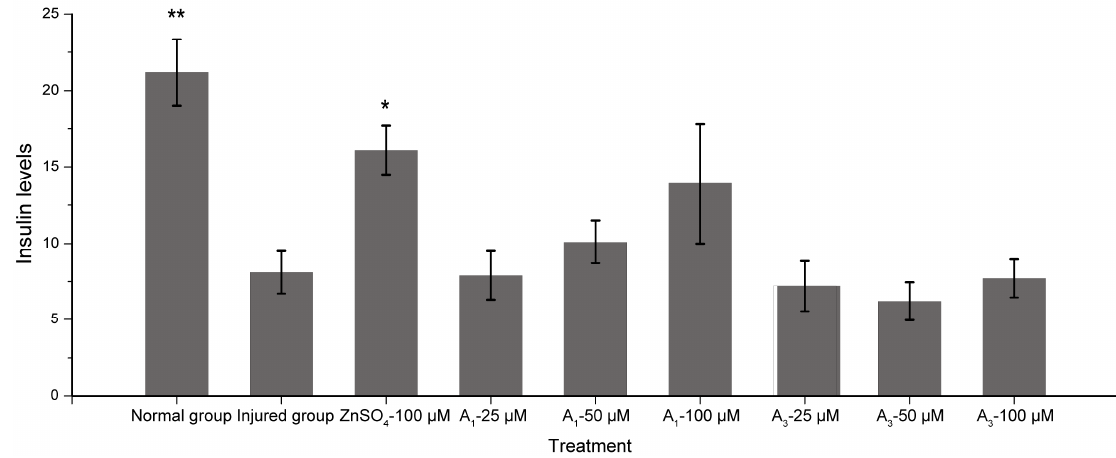
Figure 4. Cell protective effects of oleiferasaponin A 1 and oleiferasaponin A 3 on RIN-m5f cells injured by high-glucose. The values are expressed as mean ± SD. * p < 0.05, ** p < 0.01 with respect to the injured group.